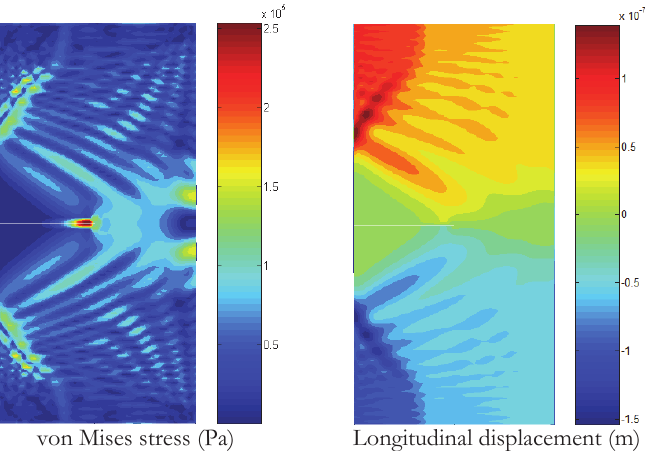
von Mises stress (Pa) Longitudinal displacement (m) Figure 13: Stress and displacement contours for the axisymmetric cross section of a cylinder with a circumferential crack of length a = 0.05 m under impulsive tension at time